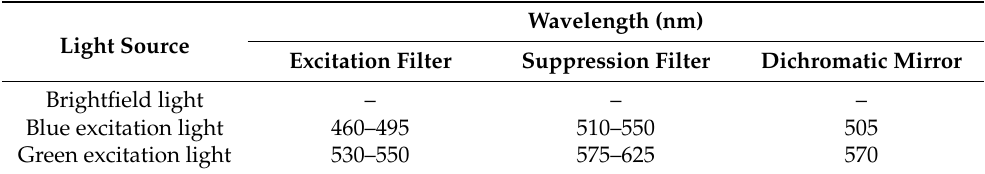
Table 1. The combined wavelength of the dichromatic mirror and filter used for visual ALC marker